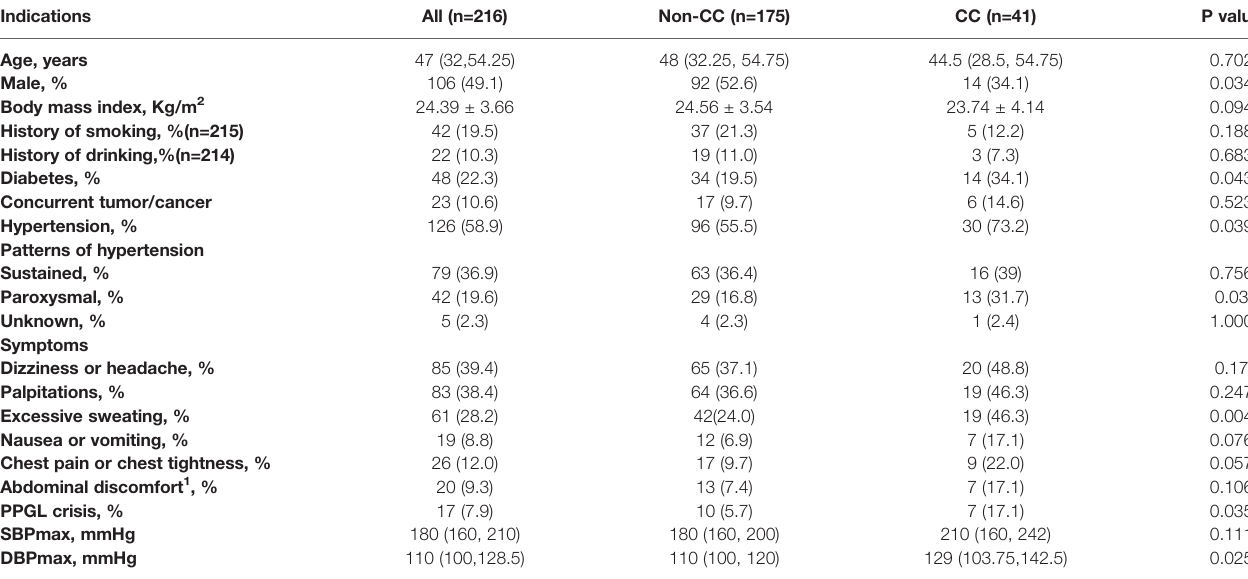
Table 1 . A total of 216 patients were included in the analysis. TABLE 1 | Clinical pro fi les of patients diagnosed with PPGL and comparisons between the non-CC and CC groups.